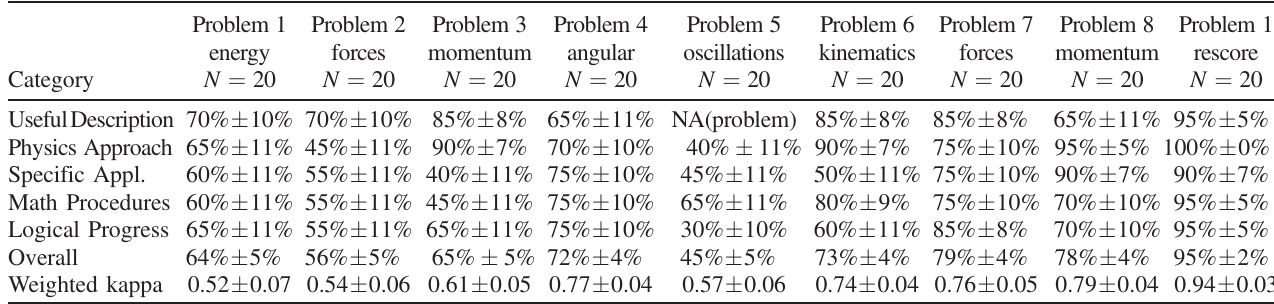
TABLE V. Percentage of perfect score agreement between the two raters for each of the eight final exam problems in the reliability study. Scores could range from 0 to 5 in each category. Percent agreement values include NA(solver) scores. Problems 1 – 5 were taken from a calculus-based mechanics course and problems 6 – 8 were from an algebra-based course. As described in the text, the agreement within 1 averaged over all categories was in excess of 97 % (cid:2) 1 %.